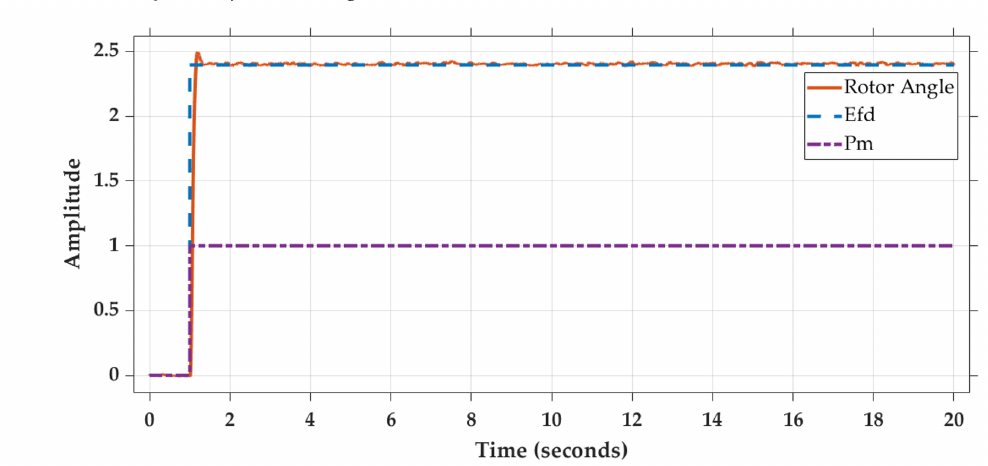
Figure 5. Rotor angle when E FD = 2.395, P m = 1, and learning rate = 10. Case Study 3. Setpoints change—P m = 0.77778 and no initial conditions.